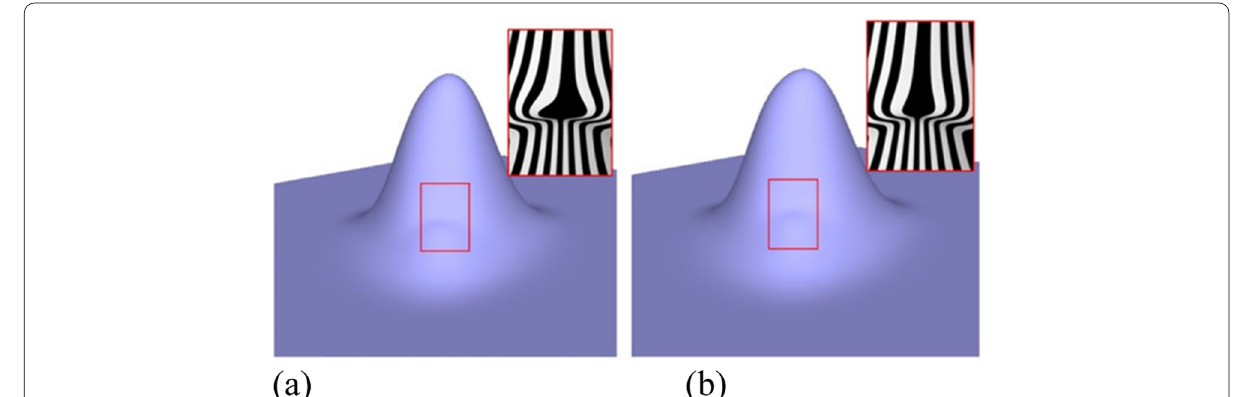
Fig. 6 Valence 3, with knot intervals of 1, 10, and 10. a Using the approach in ref. [7]; b Using the proposed method